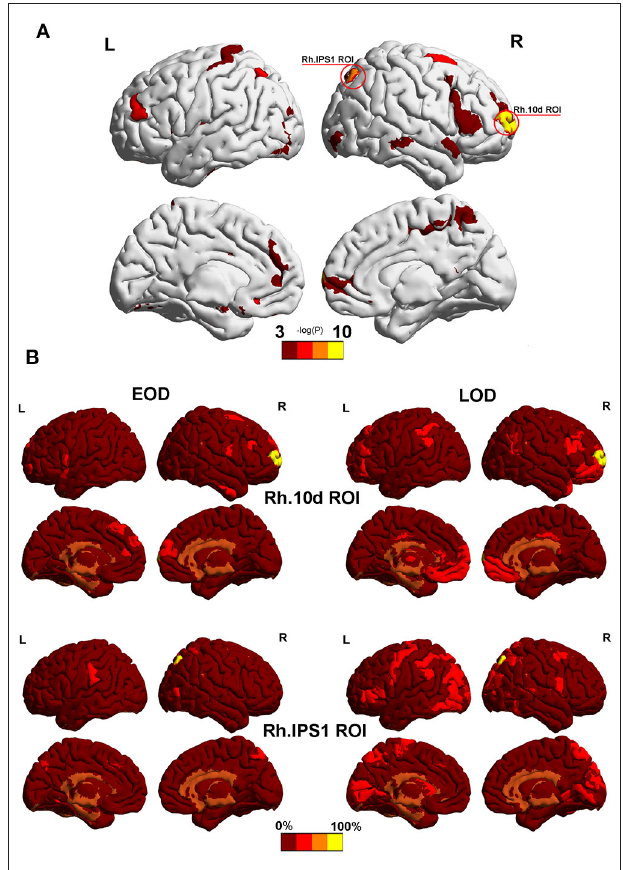
FIGURE 3 | (A) The most significantly different partitioned nodes detected by the Phi coefficient in the 2% sparsity network. The yellow area was Rh.10d.ROI and Rh.IPS1.ROI in the HCP-MMP 1.0 atlas. (B) Other nodes with the same module as Rh.10d.ROI and Rh.IPS1.ROI. Color bar represents the percentage of subjects. Mapping was performed using BrainNet Viewer software (http://www.nitrc.org/projects/bnv/).